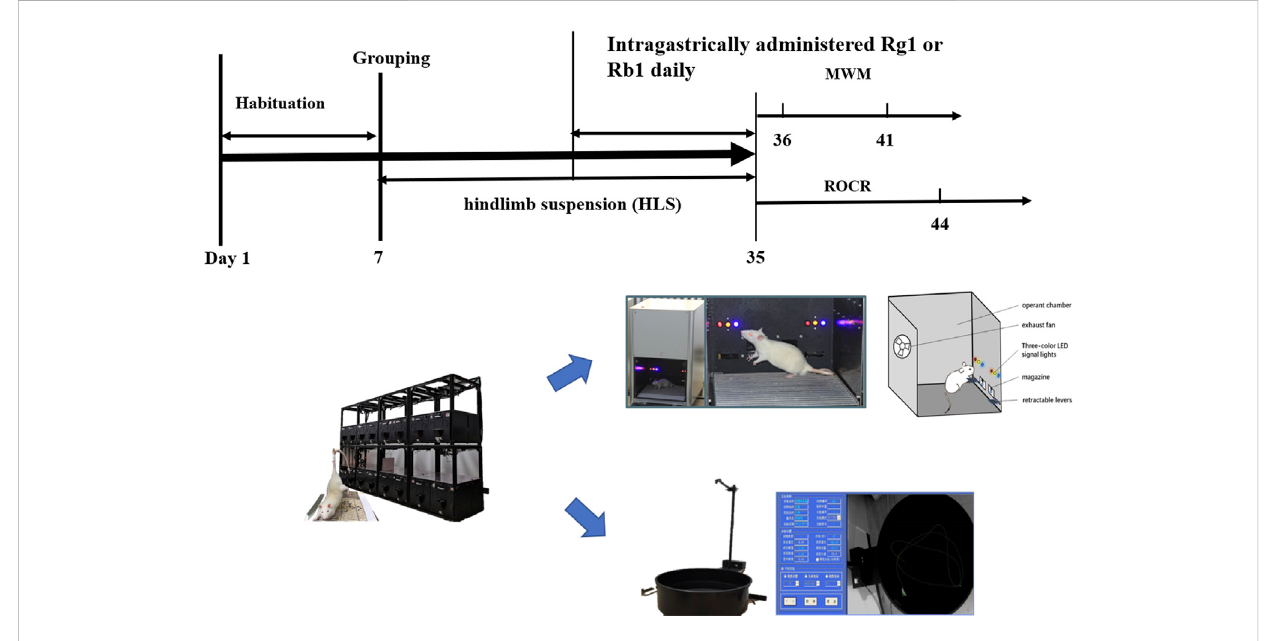
FIGURE 1 The experimental protocol of the